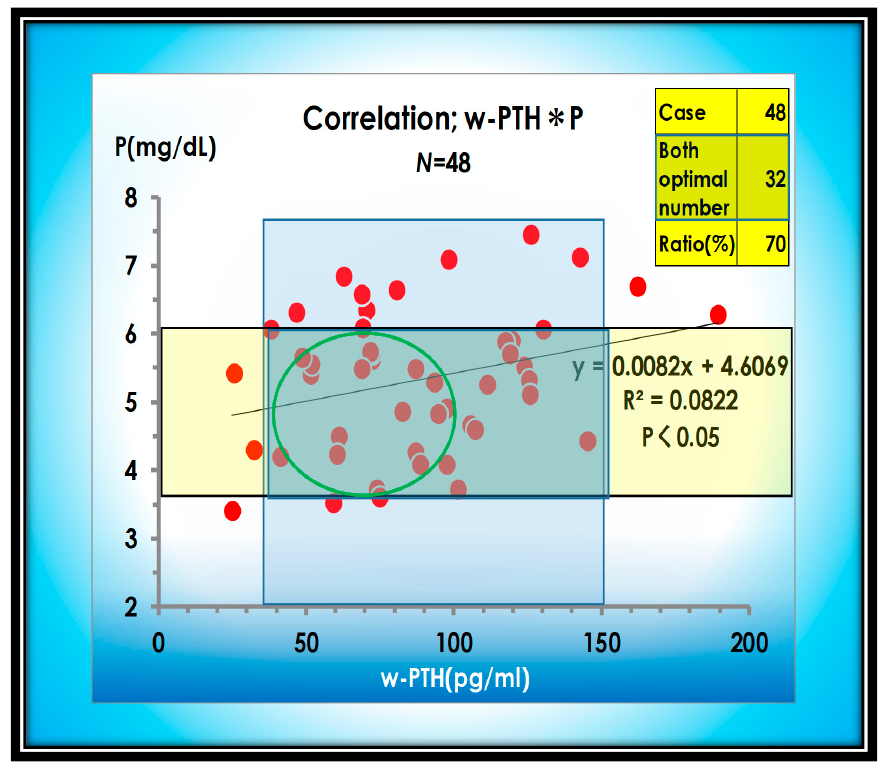
Figure 9. Correlation between P and w-PTH. P and w-PTH are positively correlated.